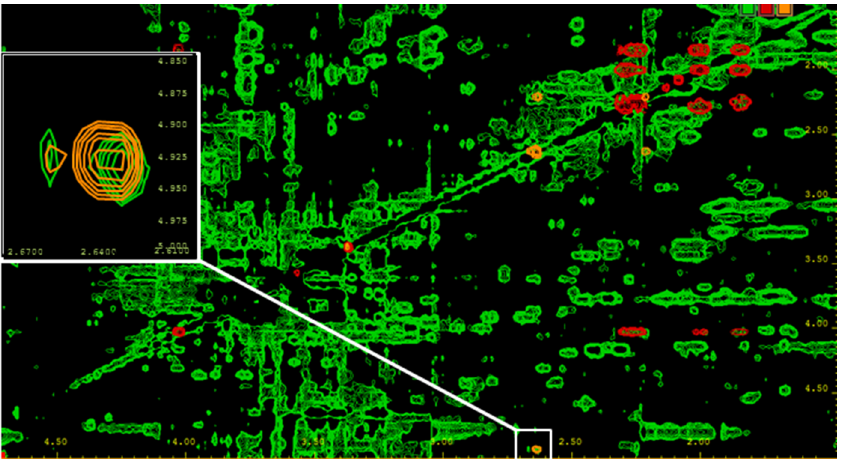
Figure 4. 2D TOCSY of a serum sample from an AML patient with an IDH2-R140Q mutation. For the removal of macromolecules, the serum was filtered using a Nanosep filtering device with a 3 kDa cutoff. Signal assignment was based on comparison with reference spectra of pure compounds. Green = serum sample; red = 2-HG reference spectrum; and orange = 2-HG-lactone reference spectrum. Besides overlapping signals for both compounds, unique signals are present, as shown in the white box for the 2-HG-lactone, and allow for the discrimination of the two metabolites. In NMR spectra of probands carrying no IDH1/2 mutation, neither 2-HG nor its lactone could be detected.